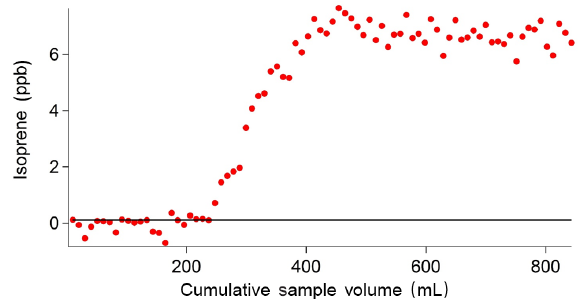
Figure 11. Results of the breakthrough volume tests. Each data point is an individual sample run of 10mL. A solid black line in- dicates a threshold (set at a LOD of 0.108ppb), above which the breakthrough volume is